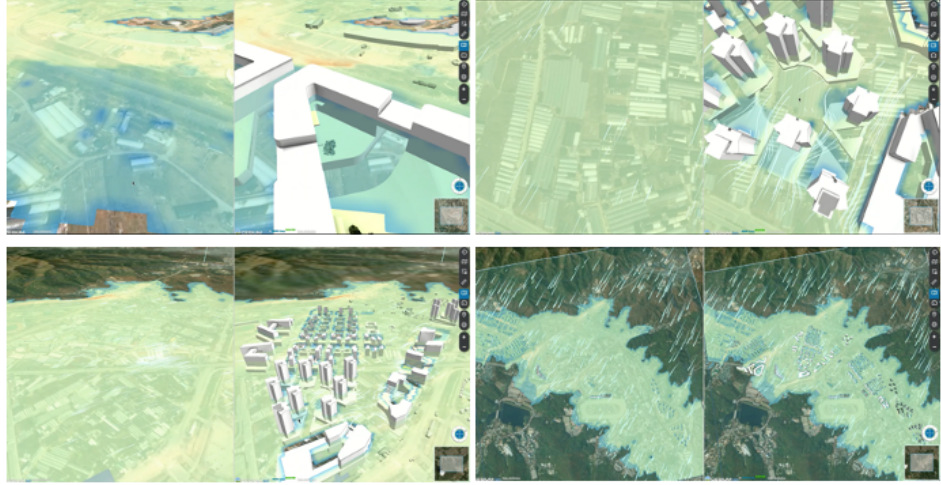
Figure 5. Wind simulation .